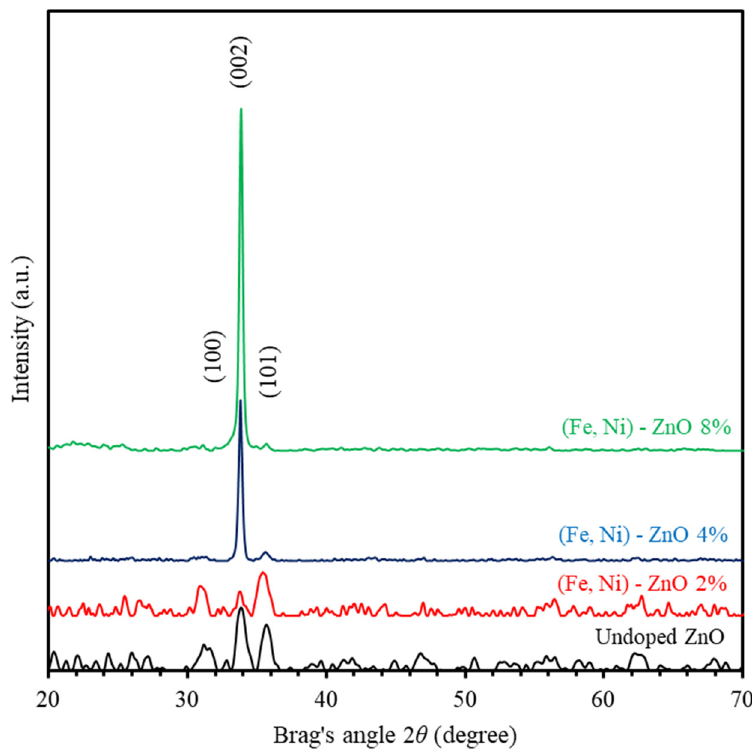
ff raction (XRD) patterns of ZnO and Fe-Ni co-doped ZnO thin Figure 1. The X-ray diffraction (XRD) patterns of ZnO and Fe-Ni co-doped ZnO thin films. Figure 1. The X-ray di